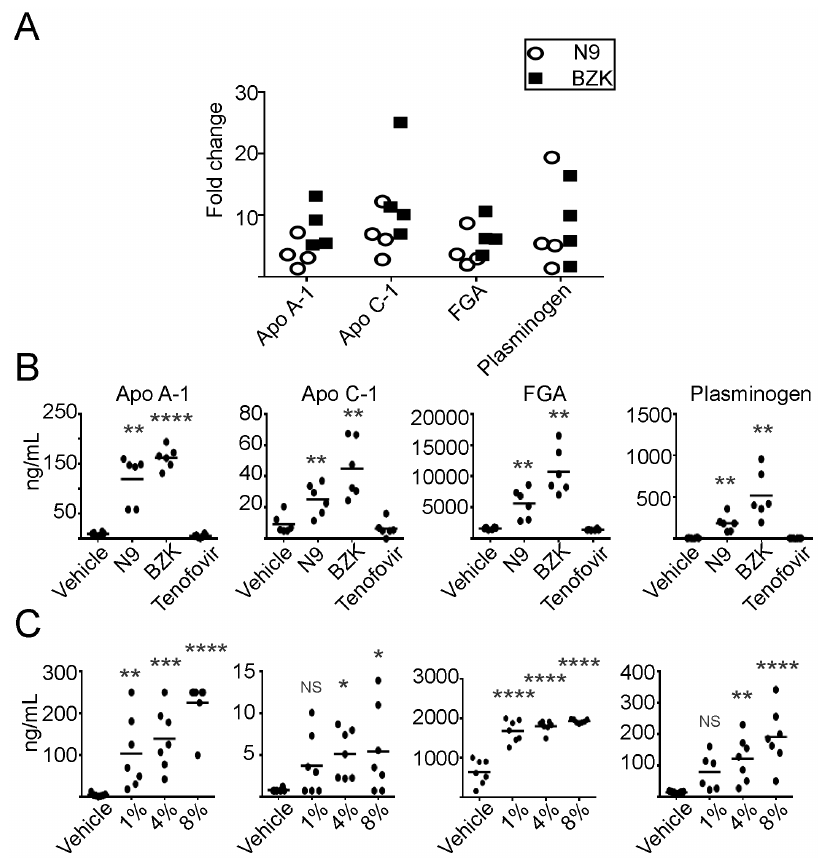
Figure 1. Quantitative proteomic analysis of mouse brush samples. (A) LC-MS/MS analysis of mouse proteins in vaginal brush samples that are affected by treatment with N9 (open, black circles) or BZK (closed squares). Shown are proteins that are increased compared to vehicle controls. The following proteins are depicted in the graph: fibrinogen alpha polypeptide isoform 2 (FGA), plasminogen (PLG), apolipoprotein A-1 (Apo A-1), and apolipoprotein C-1 (Apo C-1). Each data point represents the average of three replicates per individual experimental study. Only proteins shown to change in four studies are represented. (B) ELISA analysis of mouse proteins in vaginal brush samples that are increased in response to treatment with 8% N9 or 2% BZK. Statistical analysis was performed using a two-tailed Student’s T-test of N9 and BZK samples compared to vehicle controls (****=p # 0.0001, **=p # 0.01). (C) ELISA analysis of mouse proteins in vaginal brush samples that are increased in response to treatment with vehicle, 1% N9, 4% N9, or 8% N9. Statistical analysis was performed using a two-tailed student’s t-test of N9 and BZK samples compared to vehicle controls (****=p # 0.0001, ***=p # 0.001, **=p # 0.01, *=p # 0.05, NS=not significant).